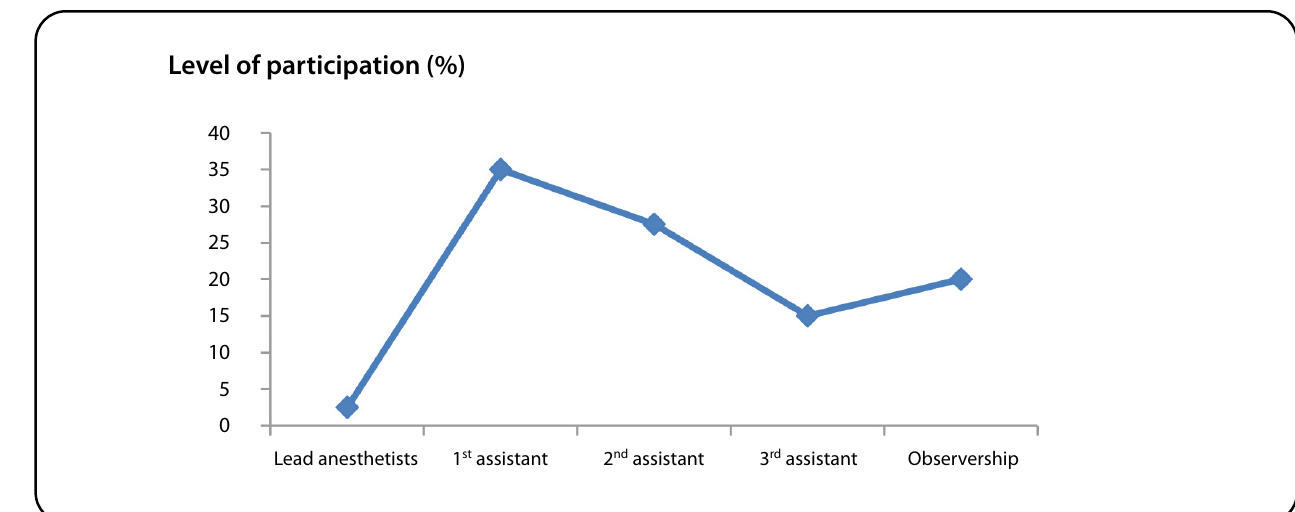
Fig. 2 - Level of participation of local